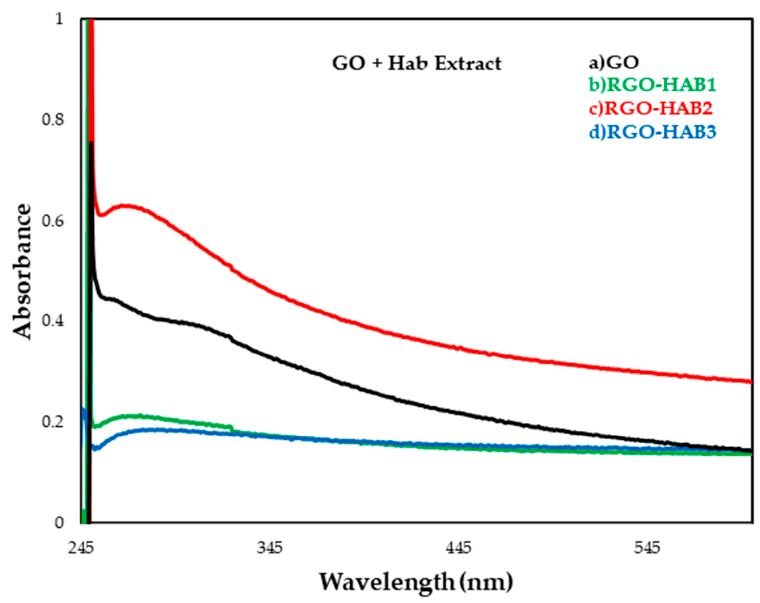
Figure 4. UV–VIS absorption spectrum of graphene oxide (GO) and reduced graphene oxide (RGO) samples with natural extracts: (a) GO (unreduced), (b) RGO-HAB1 5%, (c) RGO-HAB2 10% (d) RGO-HAB3 20%.